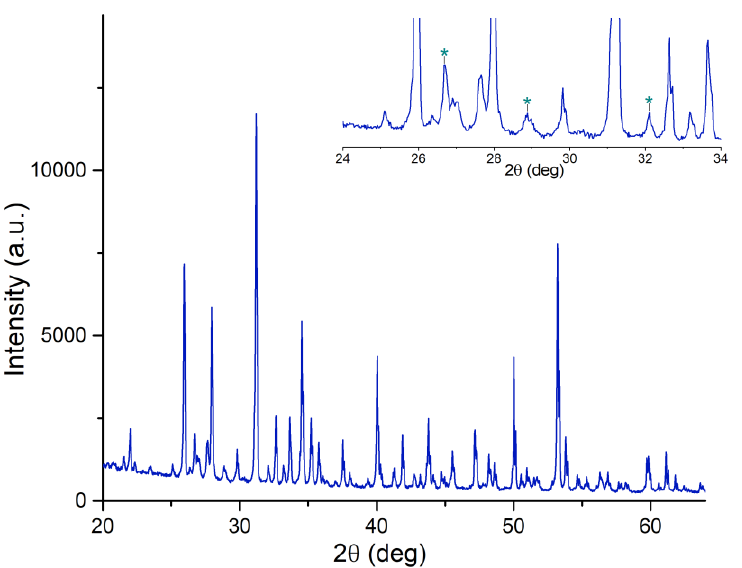
Figure 1. Experimental XRD pattern collected on Mn,Sr-TCP powder: β -TCP [01-073-4869 ICDD]. In the insert, the low-intensity region within the angular range of 24° – 34° is highlighted. The peaks assigned to Ca 2 P 2 O 7 [01-073-0440 ICDD] secondary phase are marked with asterisks.